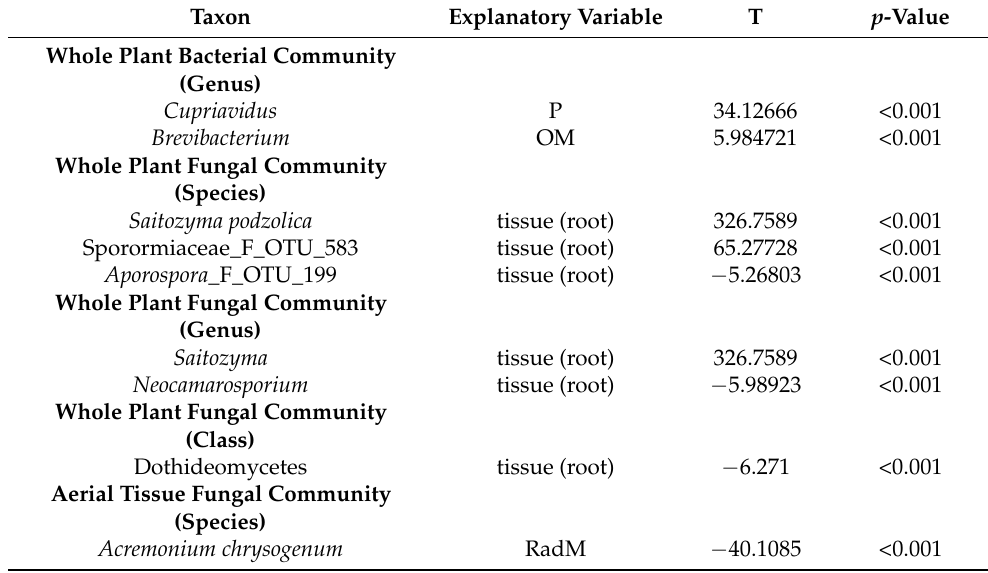
Table 4. Multiple stepwise regression model results for bacterial and fungal taxa that significantly correlated with tissue type or environmental factors (P: available phosphorus; OM: organic matter).